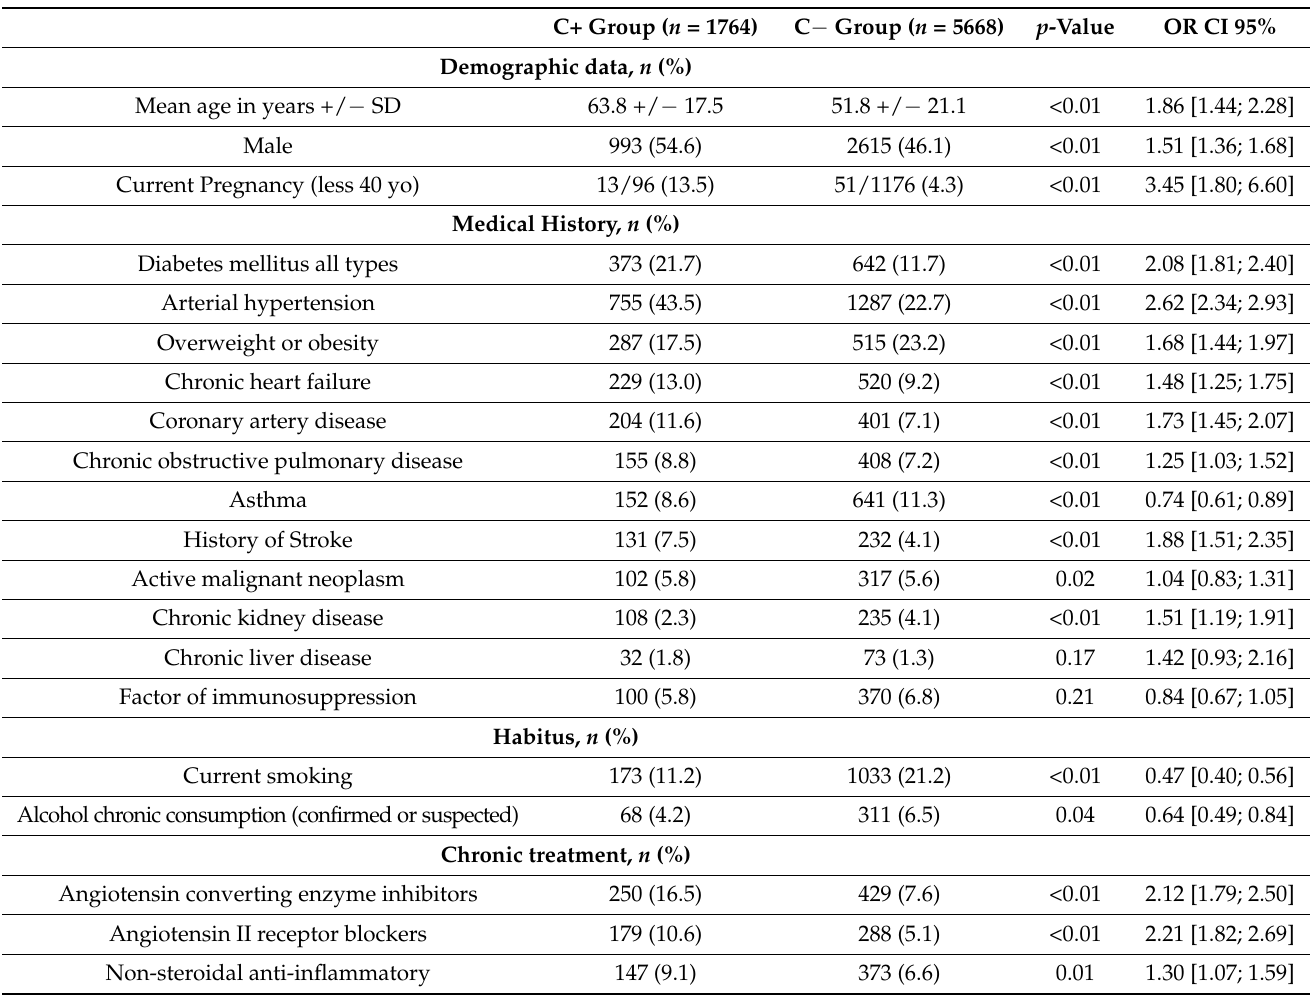
Table 2. Characteristics of patients included in the analysis ( n = 7432). (Description of missing data by variable in Table A1). C+ Group ( n =